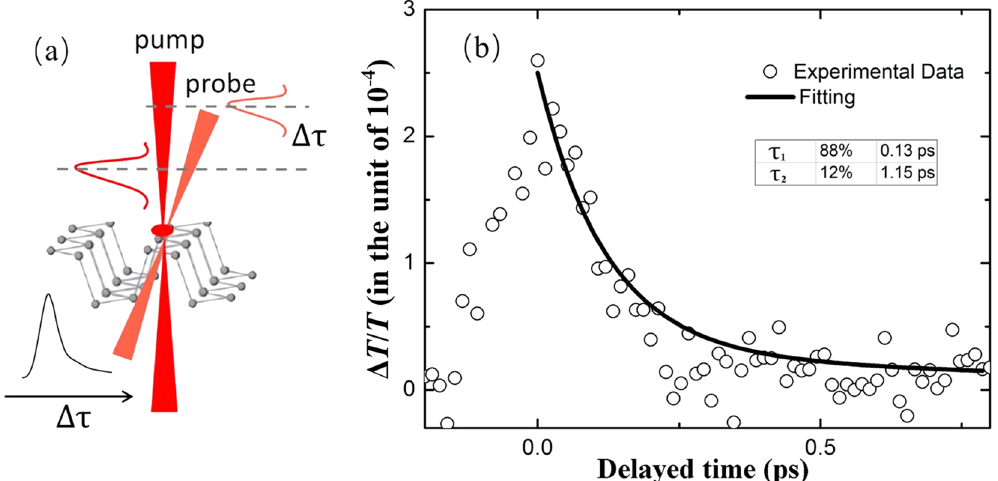
Figure 7. ( a ) Diagrammatic of carrier dynamics of BP solution; ( b ) Experimental results of pump-probe, scattered points are experimental results and solid lines are the fitting